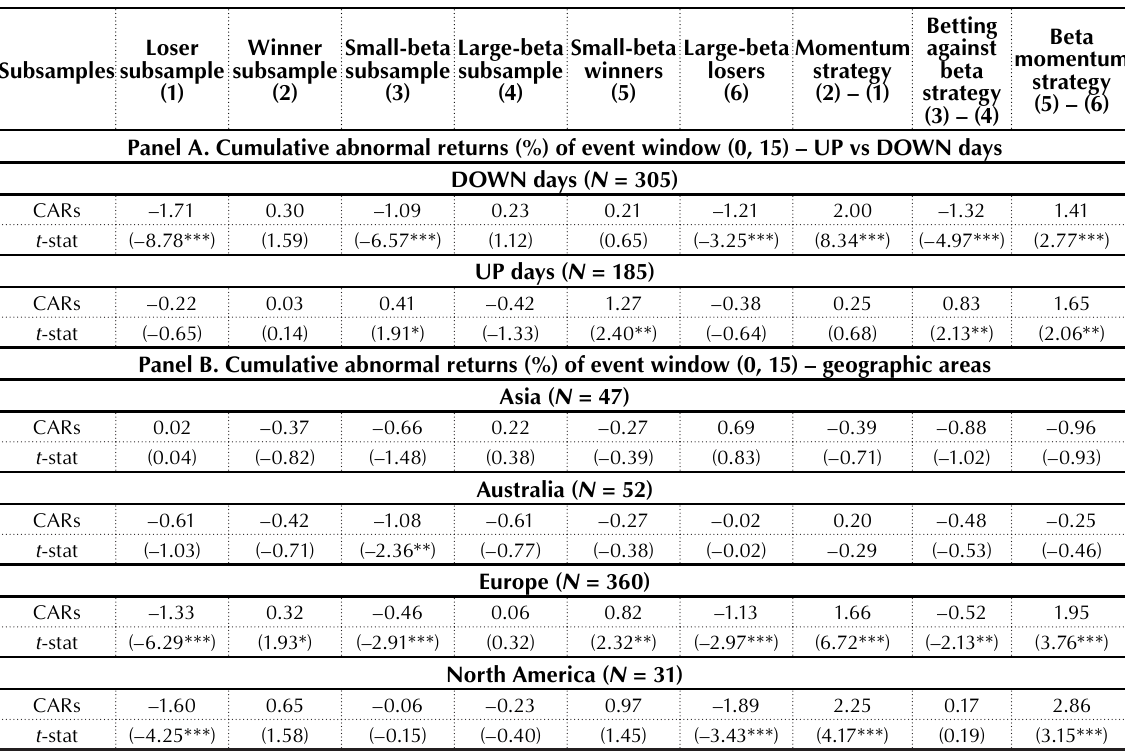
Table 4. Cumulative abnormal returns (CARs) based on DOWN vs UP days and for different geographic